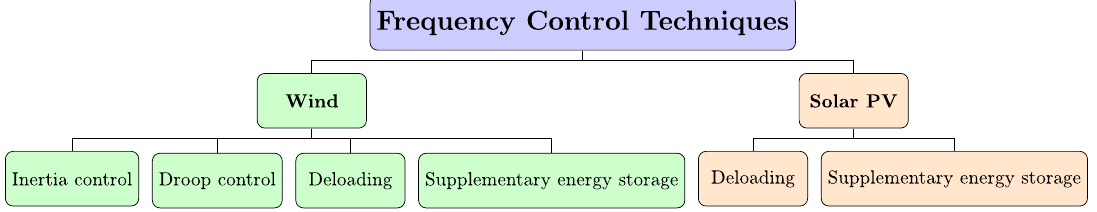
Figure 7. Predominant frequency control methods for wind and solar photovoltaic (PV) systems.